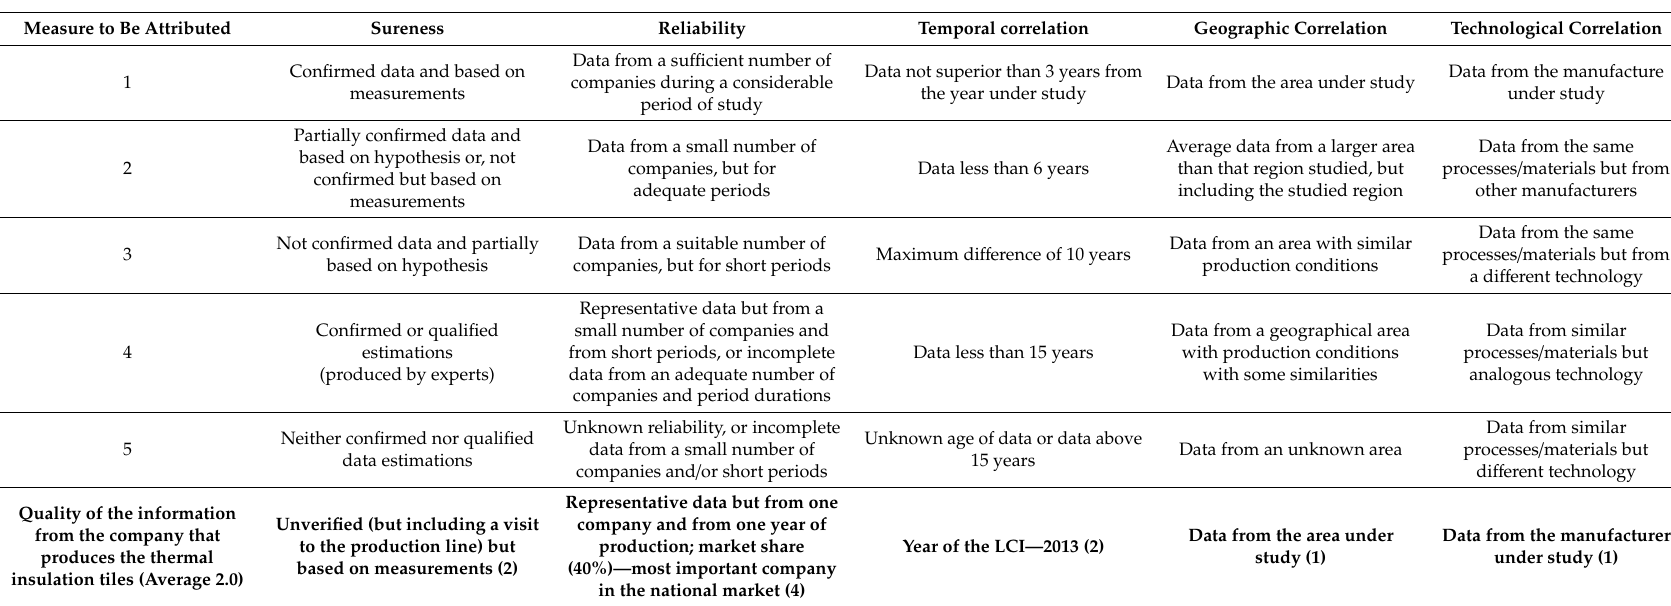
Table 4. Estimation of the quality of the information used in the Life Cycle Assessment (LCA) study and in the Life Cycle Inventory (LCI) of the thermal insulation tiles studied (adapted from